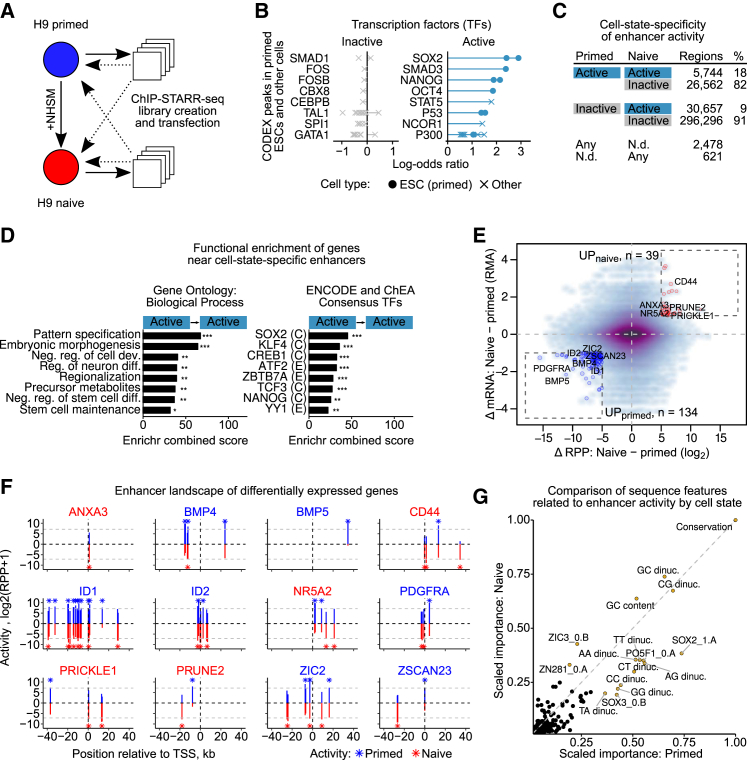
Changes in Enhancer Activity upon Induction of Naive Pluripotency(A) Overview of primed to naive conversion and ChIP-STARR-seq cross-over design.(B) Relative enrichment of TFs from CODEX (Sánchez-Castillo et al., 2015) in inactive, and active enhancers in naive hESCs. Plots like in Figure 2G.(C) Table of relative changes in enhancer activity between primed and naive ESCs.(D) Enrichment analysis (Enrichr) to test genes near enhancers active in both primed and naive ESCs against GO assignments (left) or binding sites from ENCODE and ChEA ChIP-seq (right).(E) Scatterplot contrasting average changes in enhancer activity with changes in associated gene expression. Genes with strong concordant changes in enhancer activity and gene expression are shown using the thresholds: |max(ΔRPP)| ≥ 5, |mean(ΔmRNA)| ≥ 1.(F) Visualization of enhancer activity in ChIP-STARR-seq regions near selected genes (boxes in E; TSS ± 40 kb) with differential expression in primed and naive ESCs. Bars indicate enhancer activity (RPP) in primed (blue) and naive (red) ESCs. Grey dashed bars indicate activity threshold for active enhancers. Active enhancers are highlighted with asterisks. Gene name color shows the state expressing the gene the highest.(G) Scatterplot of scaled variable importance of sequence features used to discriminate active and inactive regions in primed and naive ESCs. In both cases, a random forest classifier was trained.